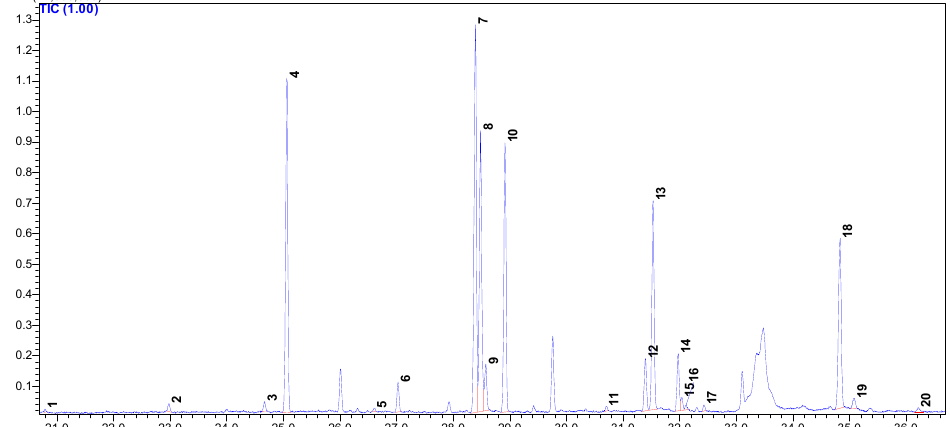
Figure A2. The representative GC-MS total ion chromatogram (TIC) profiles of fatty acid methyl esters (FAME) from whiteleg shrimp (edible flesh). 1. C14:0 (Myristic), 2. C15:0 (Pentadecanoic), 3.